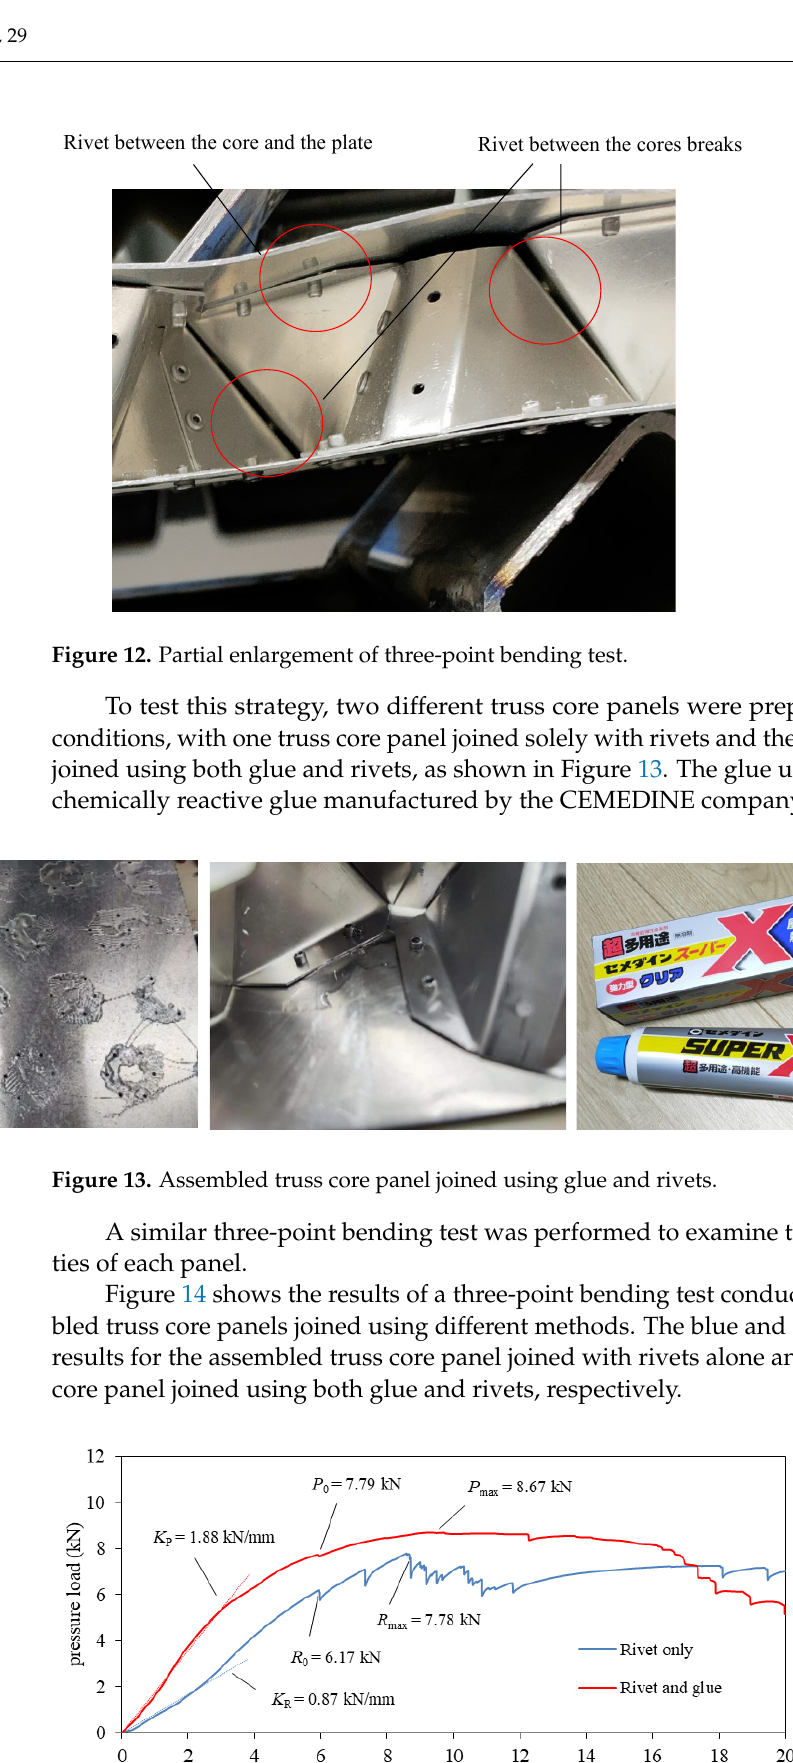
Figure 14. Three-point bending test results of assembled truss core panels joined by different meth- ods.